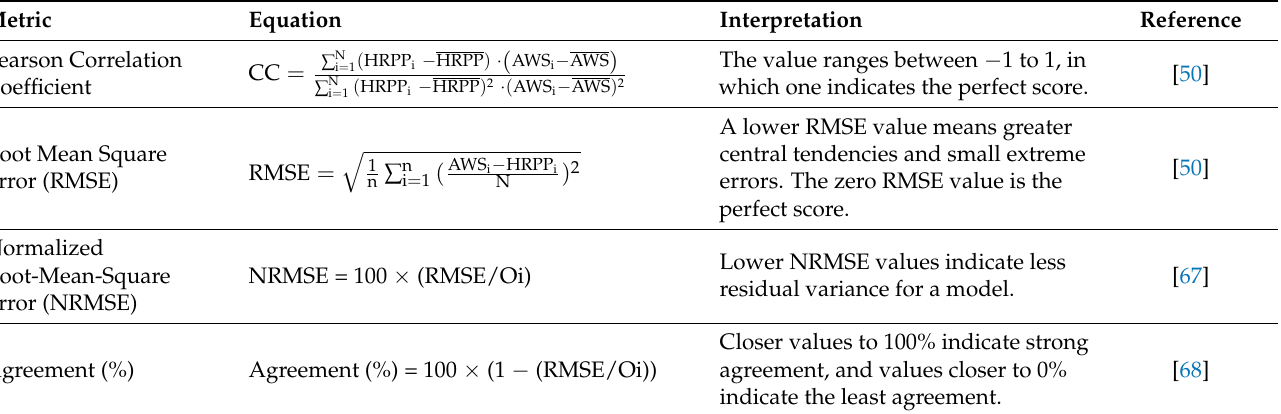
Table 2. Performance metrics used in this study to evaluate the satellite precipitation products .